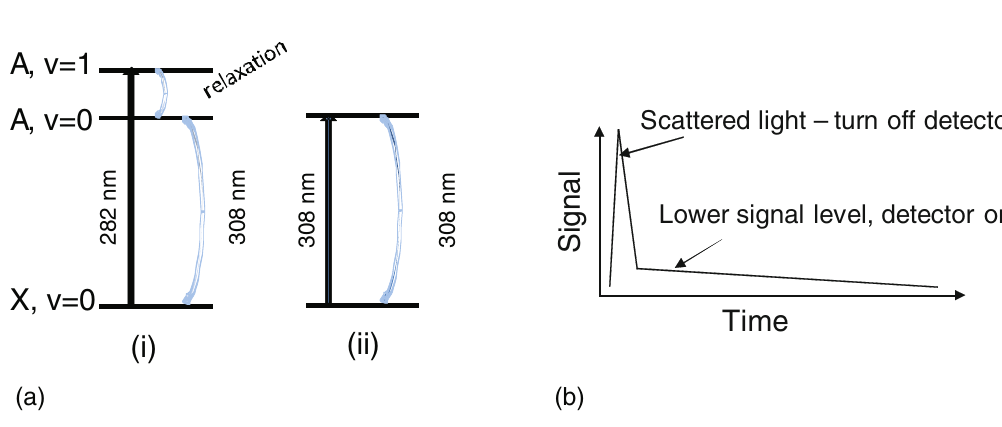
Fig. 4. (a) Laser induced fluorescence schemes. (b) Temporal discrimination against scattered